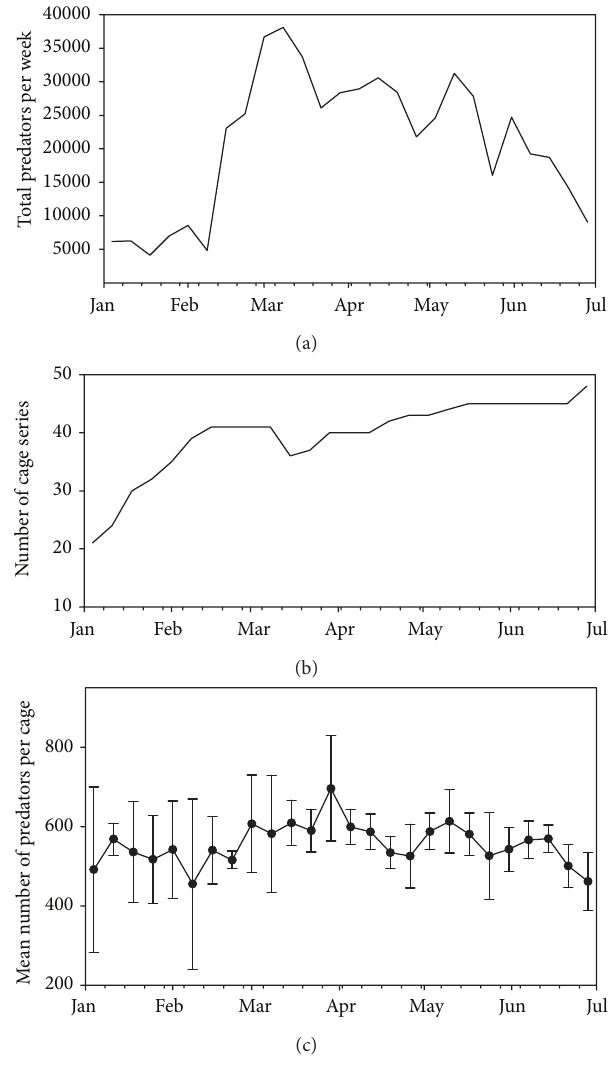
Figure 7: Production of P. persimilis . (a) Total weekly production. (b) Number of cage units in production. (c) Means of predators produced per harvested cage; brackets represent standard deviation.